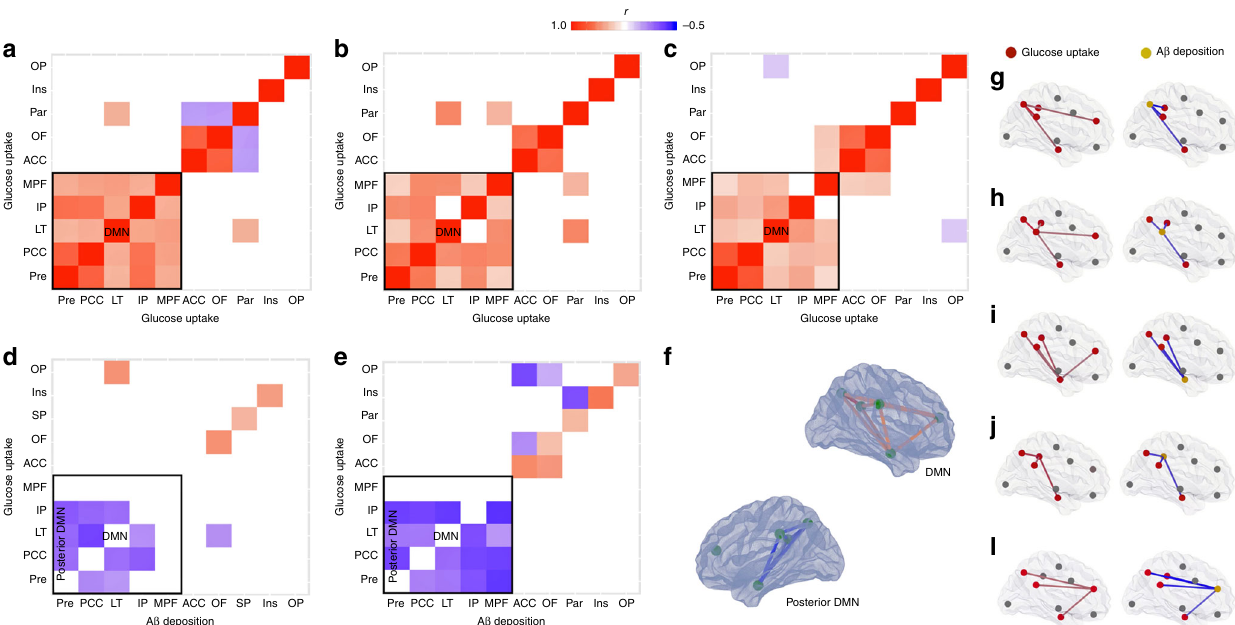
Fig. 2 Amyloid- β (A β ) is associated with hypometabolism in distant, but functionally connected brain regions. Metabolic connectivity analysis between eight regions-of-interest used to compose the global A β value in the precuneus (Pre), posterior (PCC) and anterior (ACC) cingulate, inferior parietal (IP), paracentral (Par), medial prefrontal (MPF), lateral temporal (LT), and orbitofrontal (OF), as well as two additional regions in the insular (Ins) and occipital pole (OP) cortices demonstrated that regions comprising the DMN were highly correlated with each other in ( a ) CN A β negative ( n = 99), ( b ) CN A β positive ( n = 53), and ( c ) MCI A β positive ( n = 170) individuals. Partial correlation analysis showed that A β within the DMN was associated with distant but within-network hypometabolism in ( d ) CN A β -positive and ( e ) MCI A β -positive individuals. Note that A β and its overlapping metabolism showed positive or non-correlation in these individuals. Correlation maps displayed in 3D brain surfaces show the representations of ( f ) the DMN and posterior DMN and correlations of glucose – glucose (left side) and A β -glucose (right side) in the ( g ) Pre, ( h ) PCC, ( i ) LT, ( j ) IP, and ( l ) MPF cortices in MCIs A β positive (see Supplementary Movie 1). The matrices are presented with Pearson partial correlation coef fi cients ( r ) controlled for age, gender, education, APOE ε 4 status, p-tau, gray matter density, and Bonferroni-corrected at P <